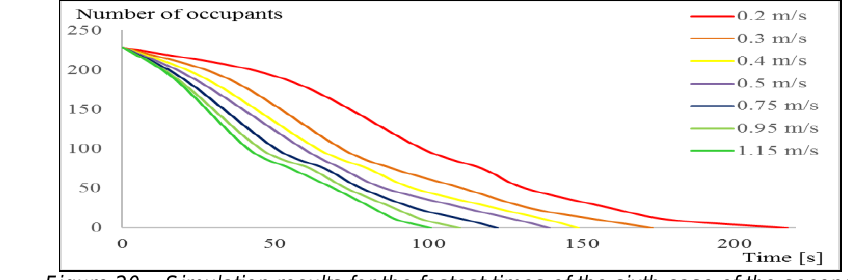
Figure 20 – Simulation results for the fastest times of the sixth case of the second scenario